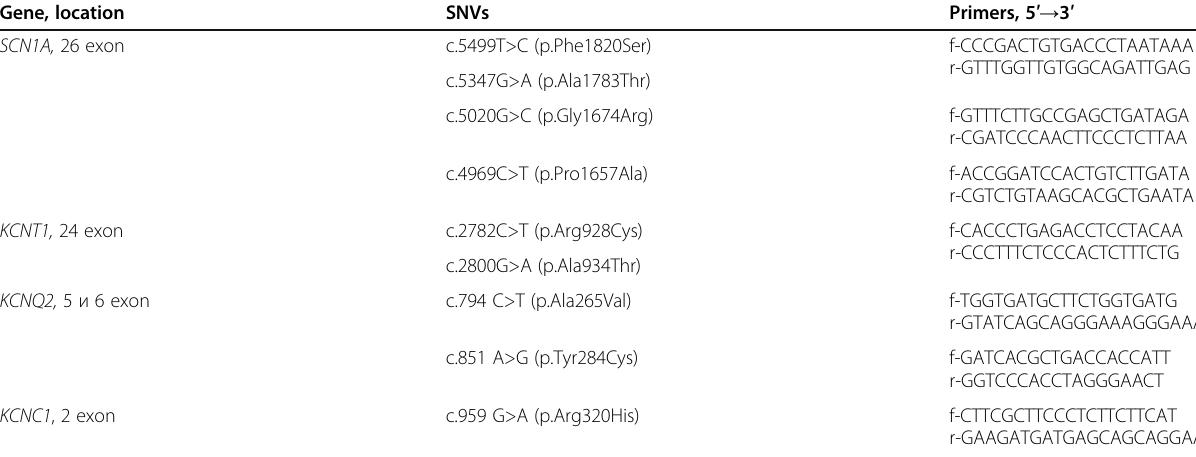
Table 1 The site-specific PCR amplification protocols Gene, location SNVs